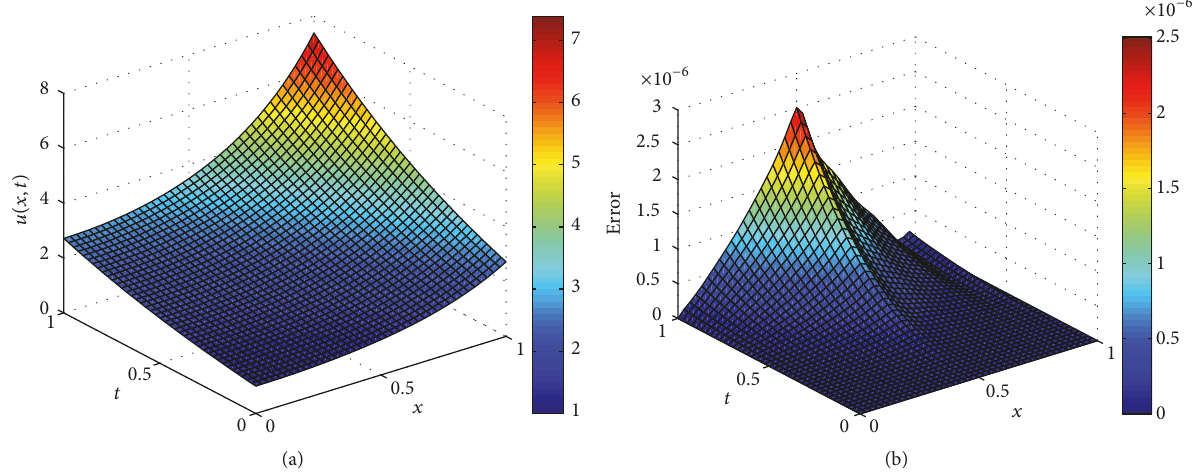
Figure 5: Approximate solution (a) and absolute error (b) for Example 5 with 𝑘 = 2 and 𝑀 = 6 .